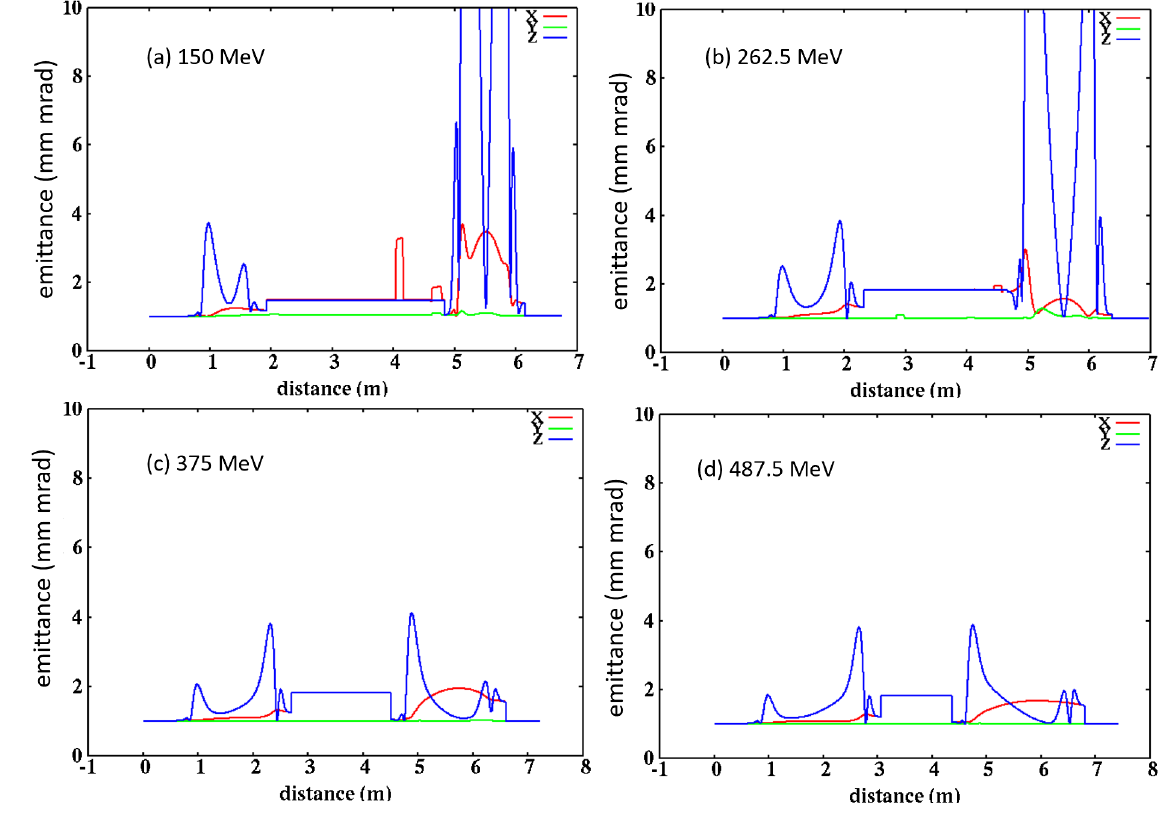
FIG. 4. Proton beam transverse and longitudinal RMS emittance evolution through the phase shifter (Table I) with 150 MeV (top left), 262.5 MeV (top right), 375 MeV (bottom left), 487.5 MeV (bottom right) kinetic energy, initial Waterbag distribution, and zero